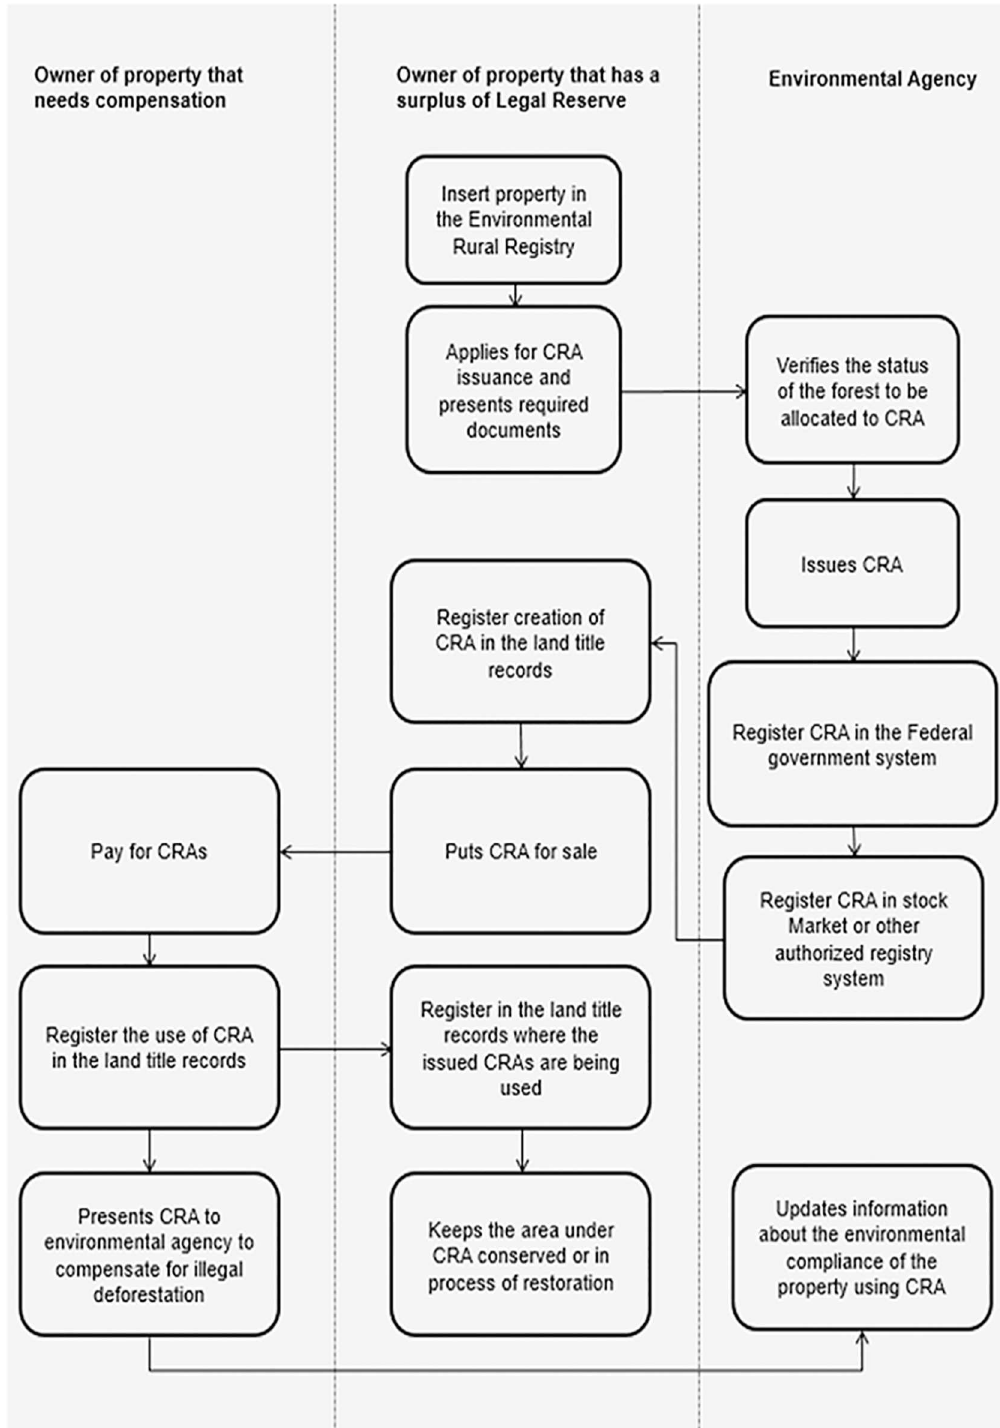
Fig 2. Steps for issuing and using CRAs to compensate illegal deforestation up to 2008.